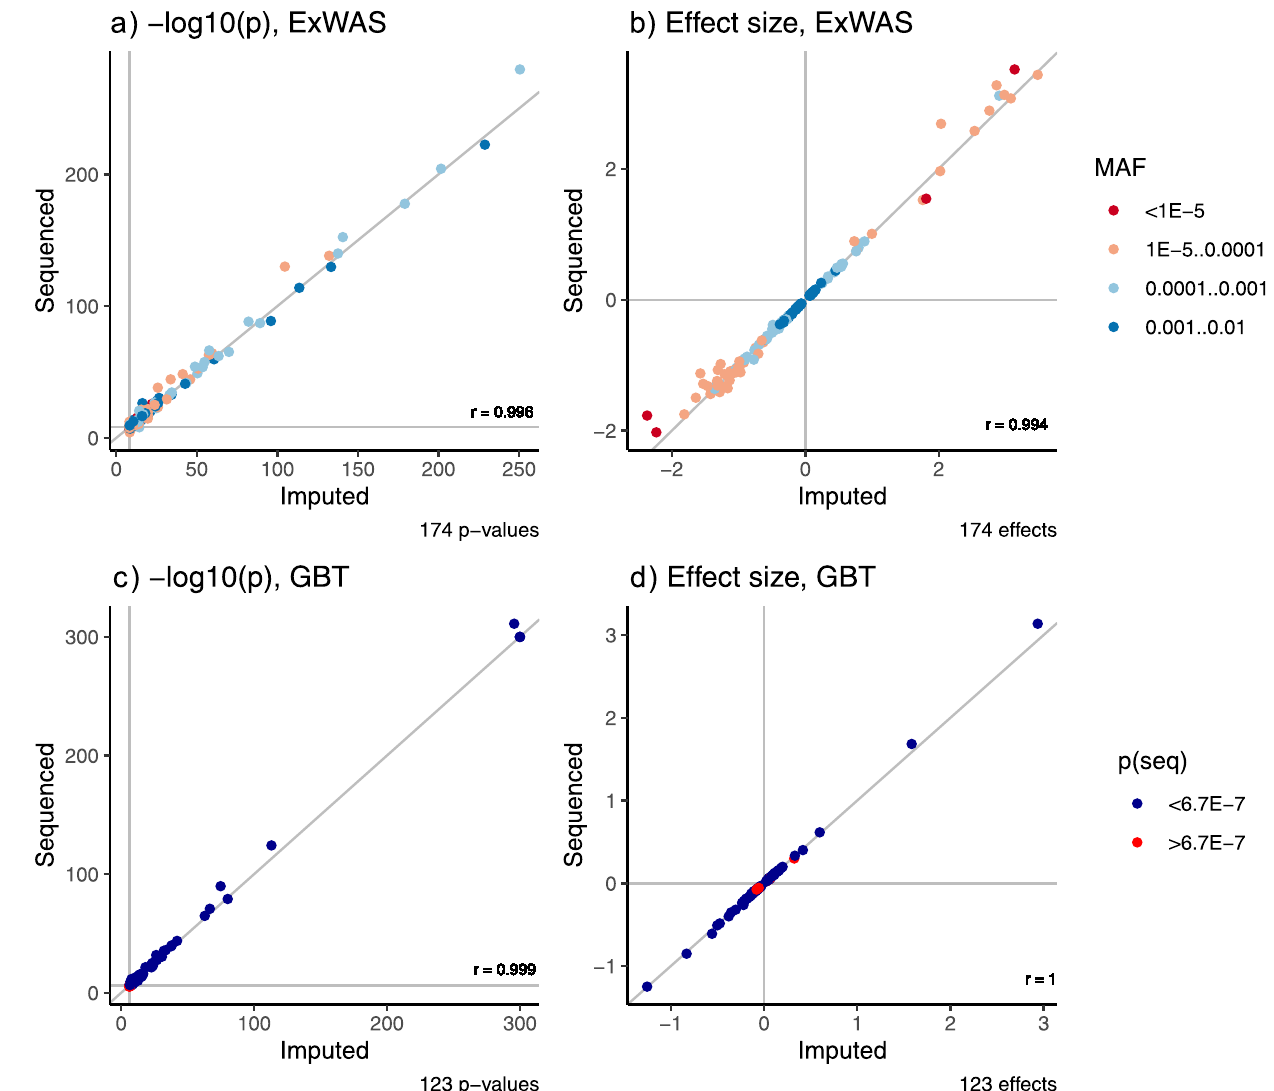
Fig. 4 | Validation of imputation-based signals using data from whole exome sequencing of all corresponding UK Biobank participants. Scatter plots of p -values ( a ) and effect sizes ( b ) for single variant (ExWAS) and − log 10 -transformed p -values ( c ) and effect sizes ( d ) for the gene-based test (GBT) − log 10 -transformed analyses comparing association statistics from partially imputed ( x -axis) and fully sequenced ( y -axis) data. Single variant results are color-coded by minor allele